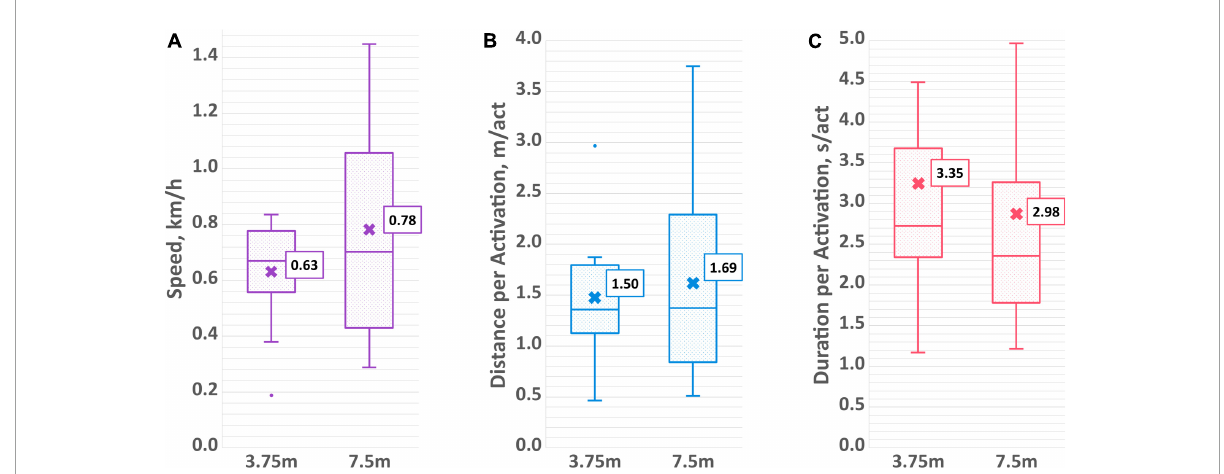
FIGURE7 Aggregated driving measures of (A) average speed, (B) average distance per activation, and (C) average duration per activation for both the 3.75 and 7.5 m distance trials.